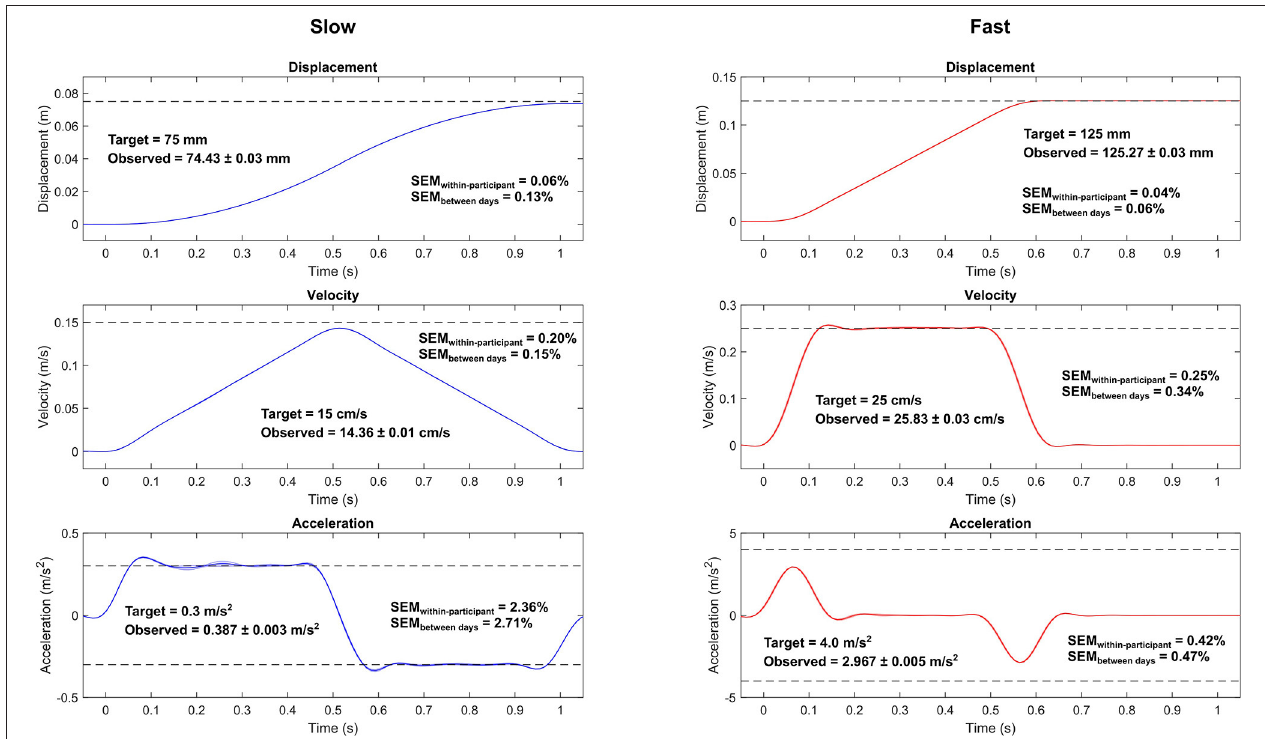
FIGURE 1 | Measured belt movement and its reliability metrics for the slow (left) and fast (right) protocols. The curves represent the mean and between-participant standard deviation (shaded area; note that the standard deviations are extremely small). Only the backward perturbations are shown, since the patterns are identical in both directions. Dashed vertical lines show the target values of the peak displacement, velocity, and acceleration based on programmed control signals of the belt. Time zero indicates the identified start of the perturbation. Note that the time scales are the same for both protocols, but the vertical scales differ. The observed values are presented as the mean and within-participant standard deviation of the peak values. SEM within − participant , within-participant standard error of measurement; SEM between days , between-day standard error of